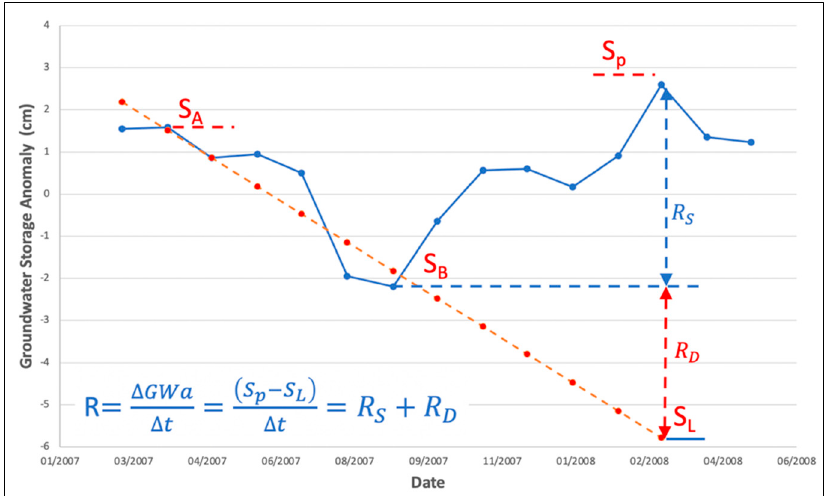
Figure 8. Conceptual diagram of the two approaches of the WTF method to show the groundwater storage anomaly (GWSa) from 01/2007 to 06/2008 in the Iullemeden basin (modified from Wu, et al. [60].